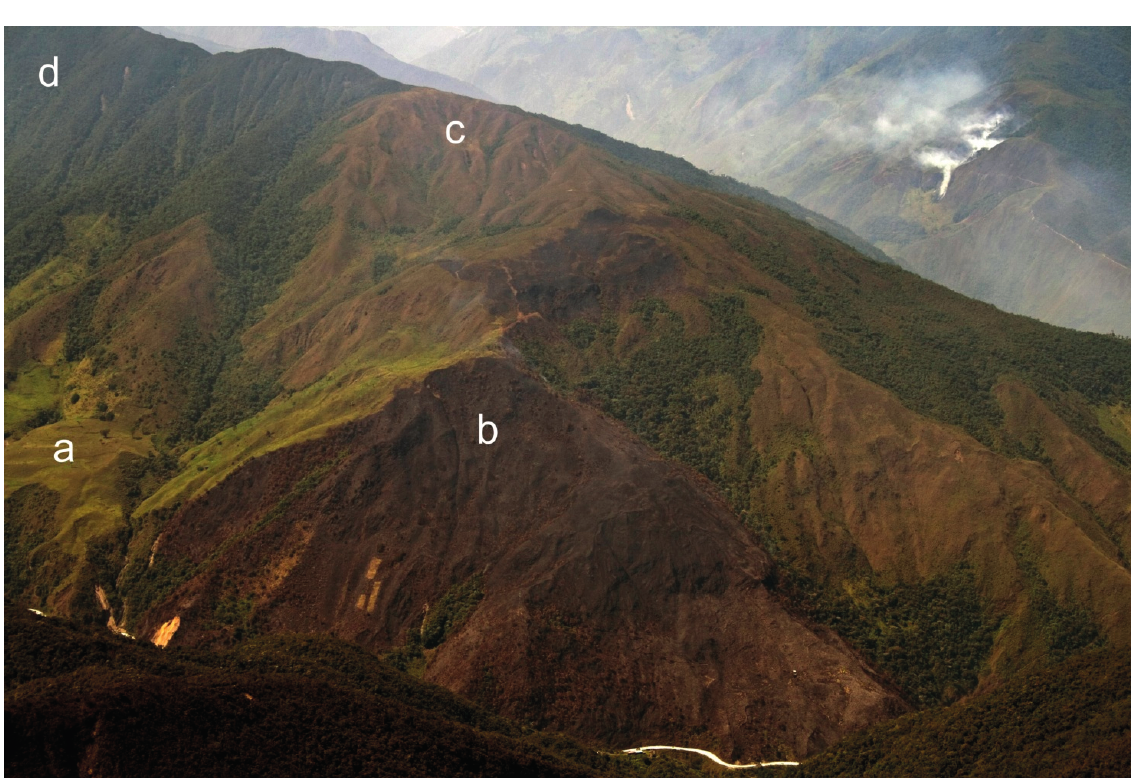
Figure 2. Landscape in the San Francisco River Valley during the dry season: ( a ) pastures; ( b ) recently burned areas; ( c ) bracken-infested area; and ( d ) forest (Photograph by Sandro Makowski Giannoni, October